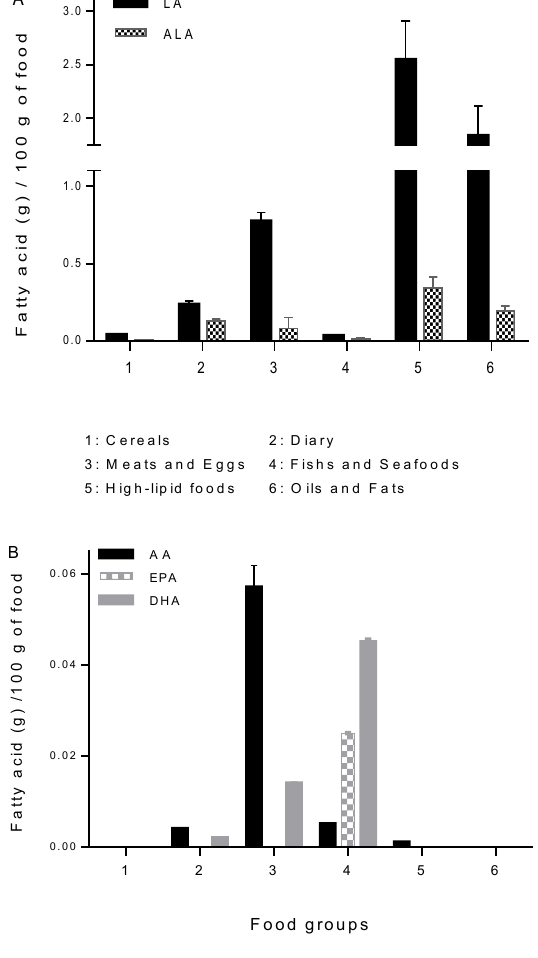
Figure 1. Data are expressed as the mean ± SE and represent the content of each fatty acid (g)/100g of food. Cereals, all cereals and potatoes; dairy products, milk, cheese, fresh cheese and yogurts; meats and eggs, beef, chicken, pork and turkey meat and all their derived products, as well as eggs; fish and shellfish, hake, mackerel, tuna, salmon and shellfish (fresh and frozen); high-lipid foods, olives, almonds, peanuts, walnuts, avocado, pistachios and hazelnuts; oils and fats, vegetable oils (mainly sunflower, soybean, canola, grape seed and olive oil) and fats (lard, butter, margarine, mayonnaise and